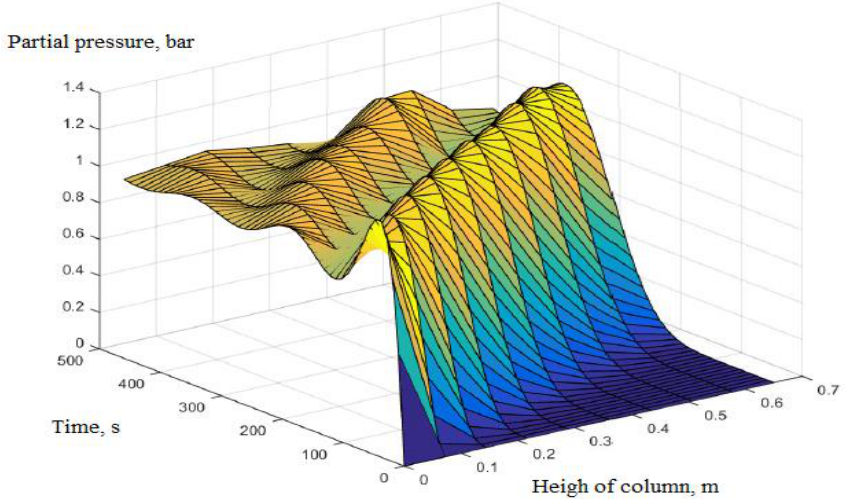
Figure 4. The result of partial pressure (O 2 ) following over time and height of column at 5 bar.